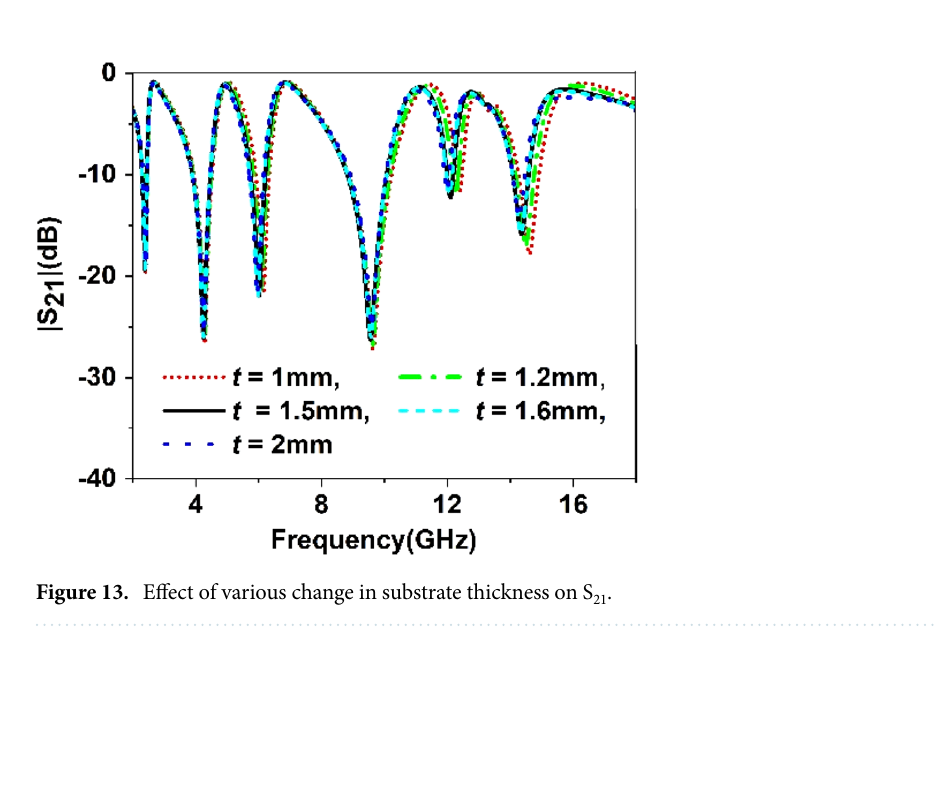
Figure 12. Study of variation of |S 21 | with circular ring split gap, d4.